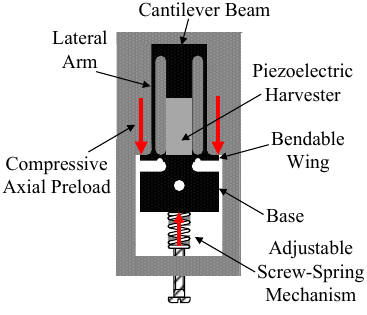
Figure 16. Schematic representation of the axial loads based MTT proposed in [32,33].